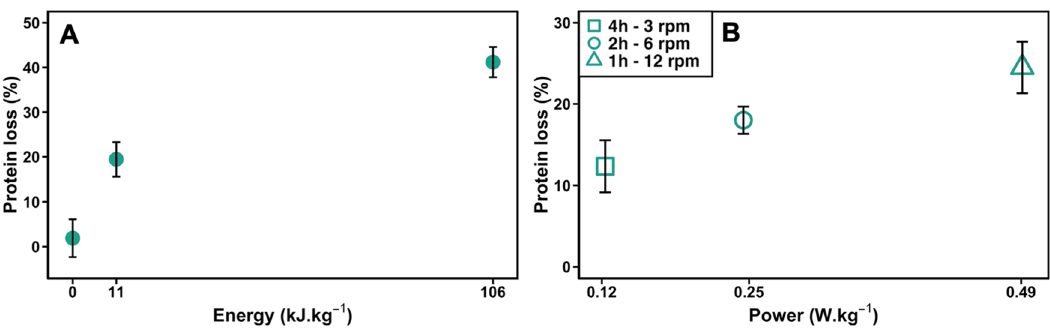
Figure 3. Evolution of protein loss for YPE in PP tubes under agitation as a function of ( A ) the energy supplied to the system for a fixed duration of 24 h and a fixed power of 1.23 W/kg, ( B ) the power applied for a fixed energy of 1.8 kJ/kg. All samples were mixed at 6 °C on a rotating wheel.